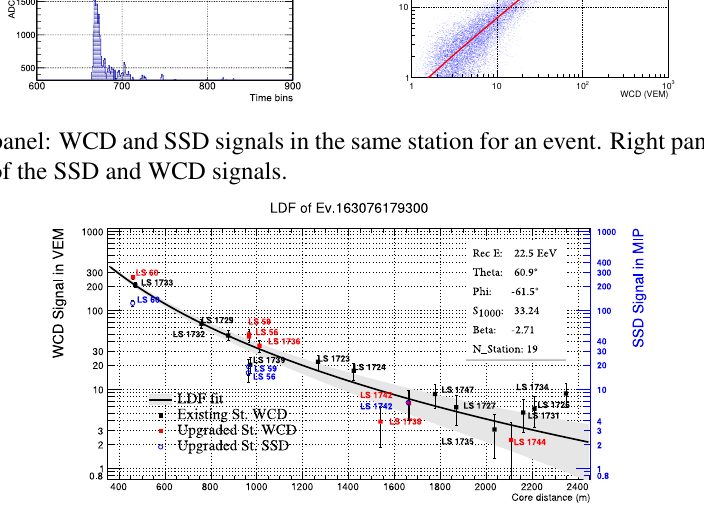
Figure 4: Signals in upgraded stations from an event compared with its LDF reconstructed with regular 1500 m